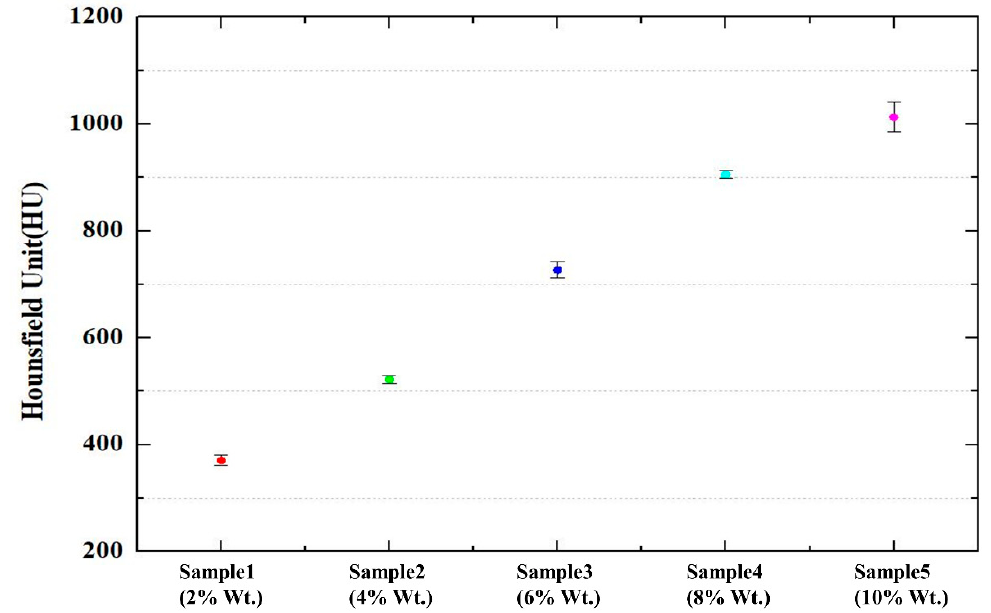
Figure 5. Comparison of HU values at wt. ratios from 2% to 10% for fabricated PLA/PBAT/BaSO 4 materials. Table 2. Comparison of HU values based on the produced PLA+PBAT+BaSO4 mixed filament ratio. BaSO 4 Ratio (%)